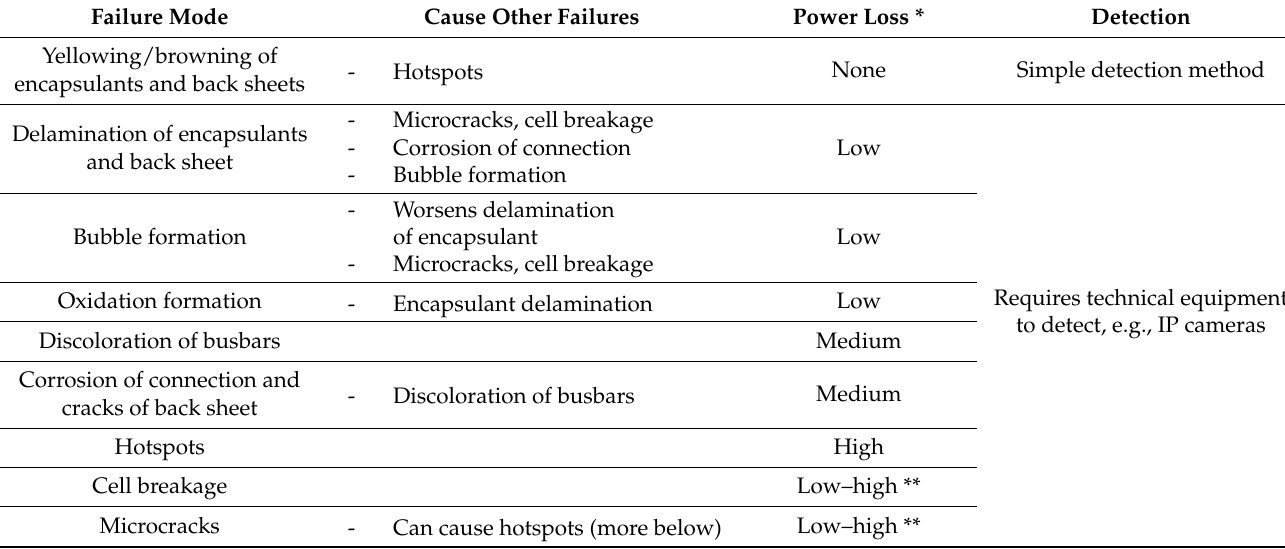
Table 1. PV mechanical failure